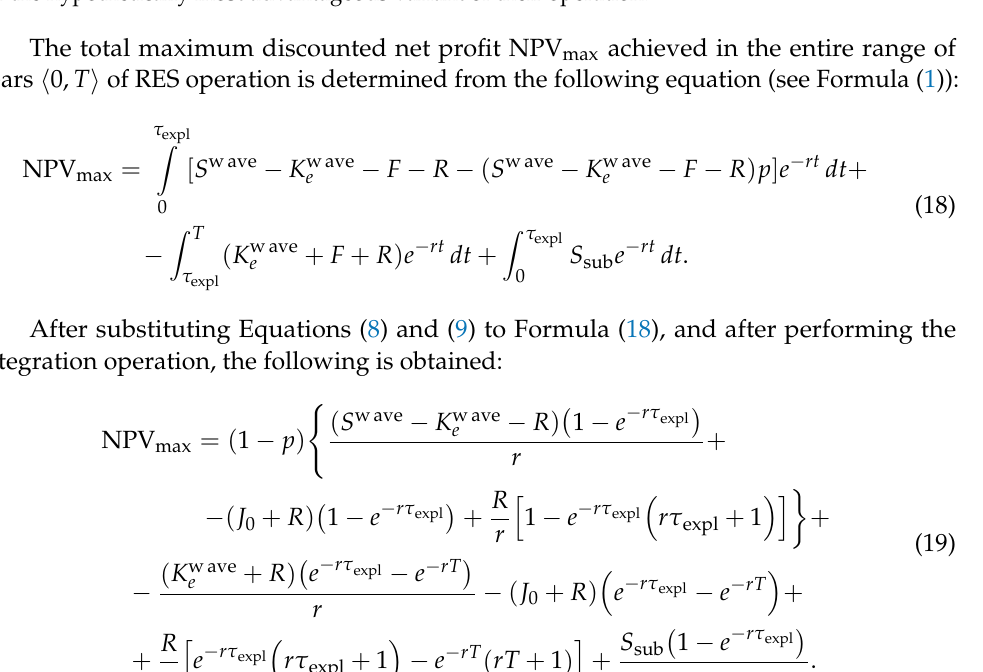
Figure 3. Time-dependent course for the weighted average revenues and the costs of RES operation for the hypothetically most advantageous variant of their